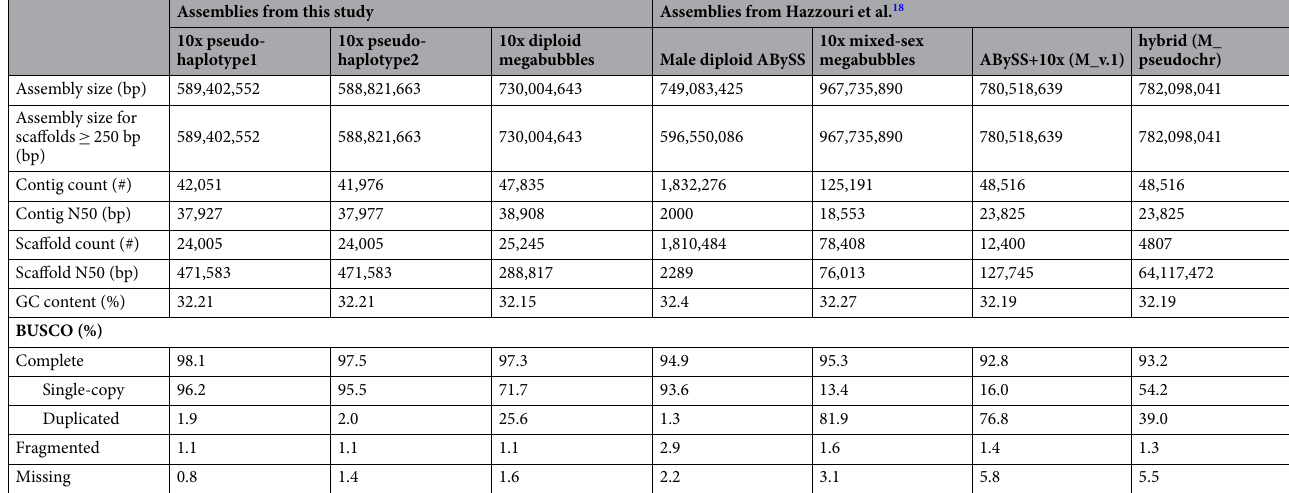
Table 1. General assembly statistics and BUSCO scores for RPW genome